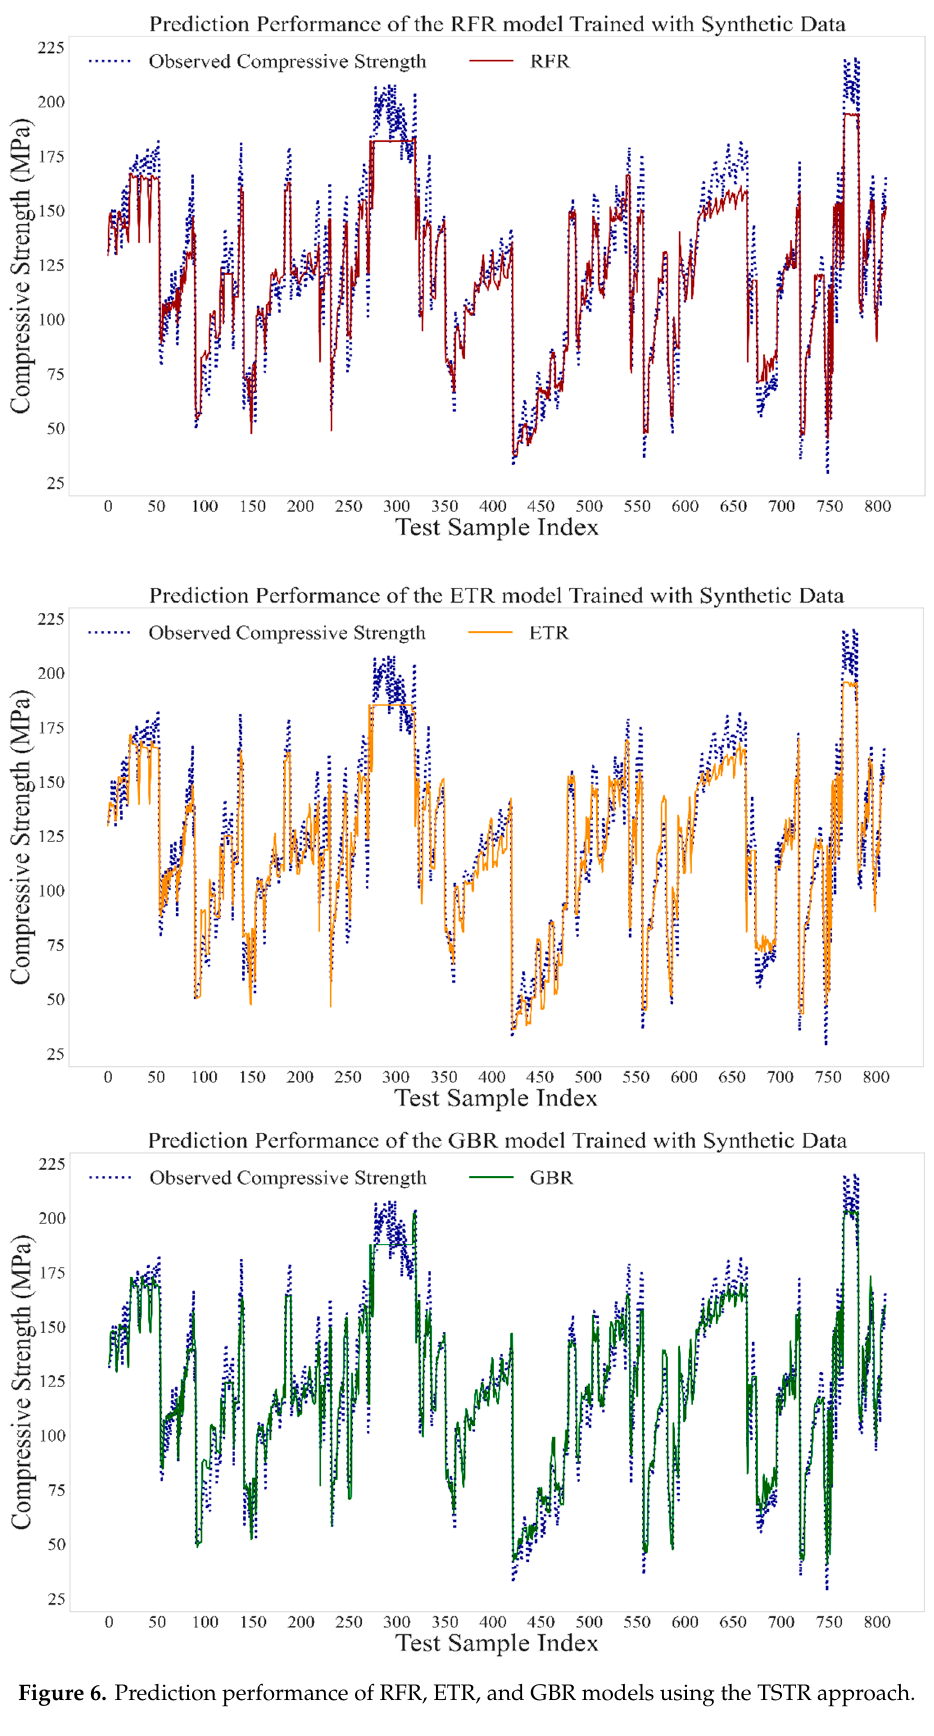
Figure 6. Prediction performance of RFR, ETR, and GBR models using the TSTR approach.